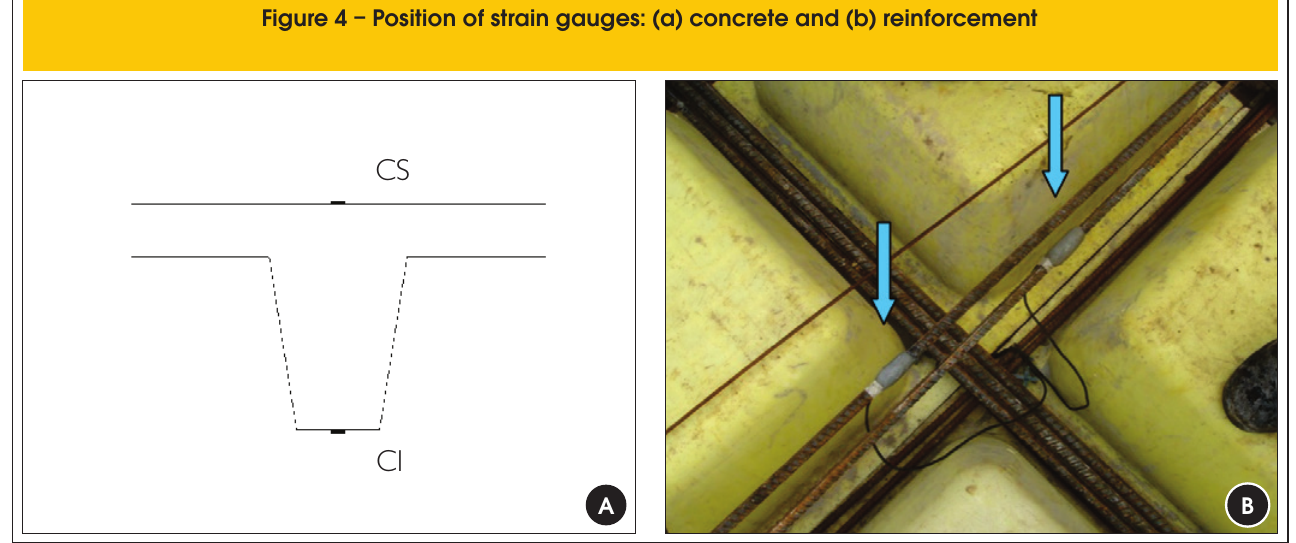
Figure 4 – Position of strain gauges: (a) concrete and (b) reinforcement